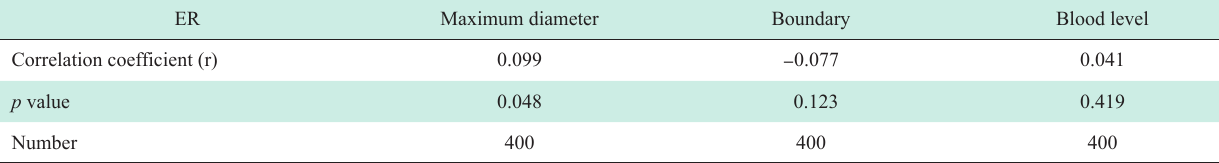
Table 4 Correlation between tumor maximum diameter, tumor boundary, blood flow signal classification and Ki-67